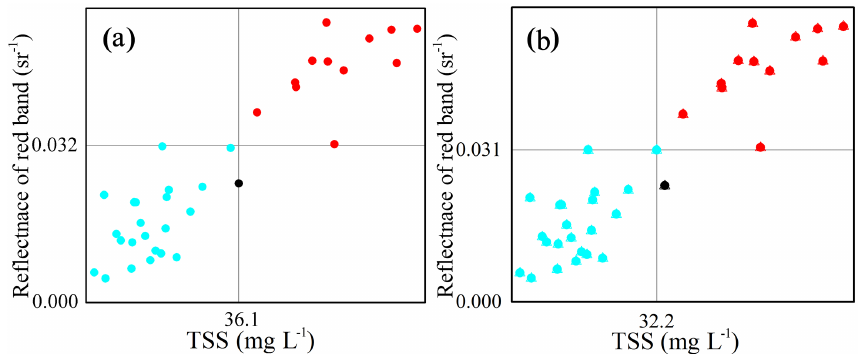
Figure 5. Relationship between the Landsat red-band reflectance and corresponding TSS concentration. (a) OLI sensor; (b) ETM + and TM